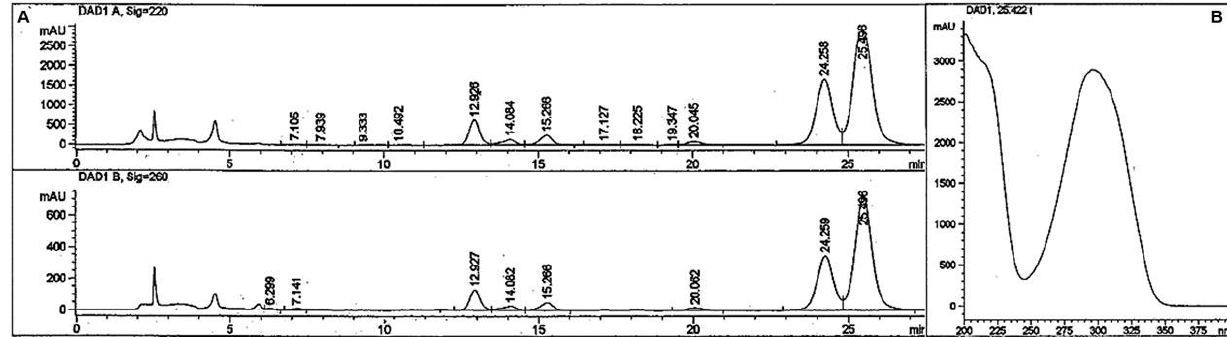
Figure 1. Elution profile of reaction mixture on high performance liquid chromatography, C18 column. Aliquots of the partially purified material obtained from the TLC column (see Materials and Methods) were dissolved in methyl alcohol (0.3 mL) and a 50 µL sample was injected onto a Luna C-18, 5 µ m column (250 × 4.6 mm) provided with a pre-column. Elution was performed with a 35 min, 68% CH3CN/water isocratic system with a flow rate of 1.0 mL/min. The lines represent the absorbance at 220 nm ( A , upper panel) and at 260 nm ( A , lower panel). The absorbance of the peak at 25.4 min retention time at different wavelengths is shown in ( B ).